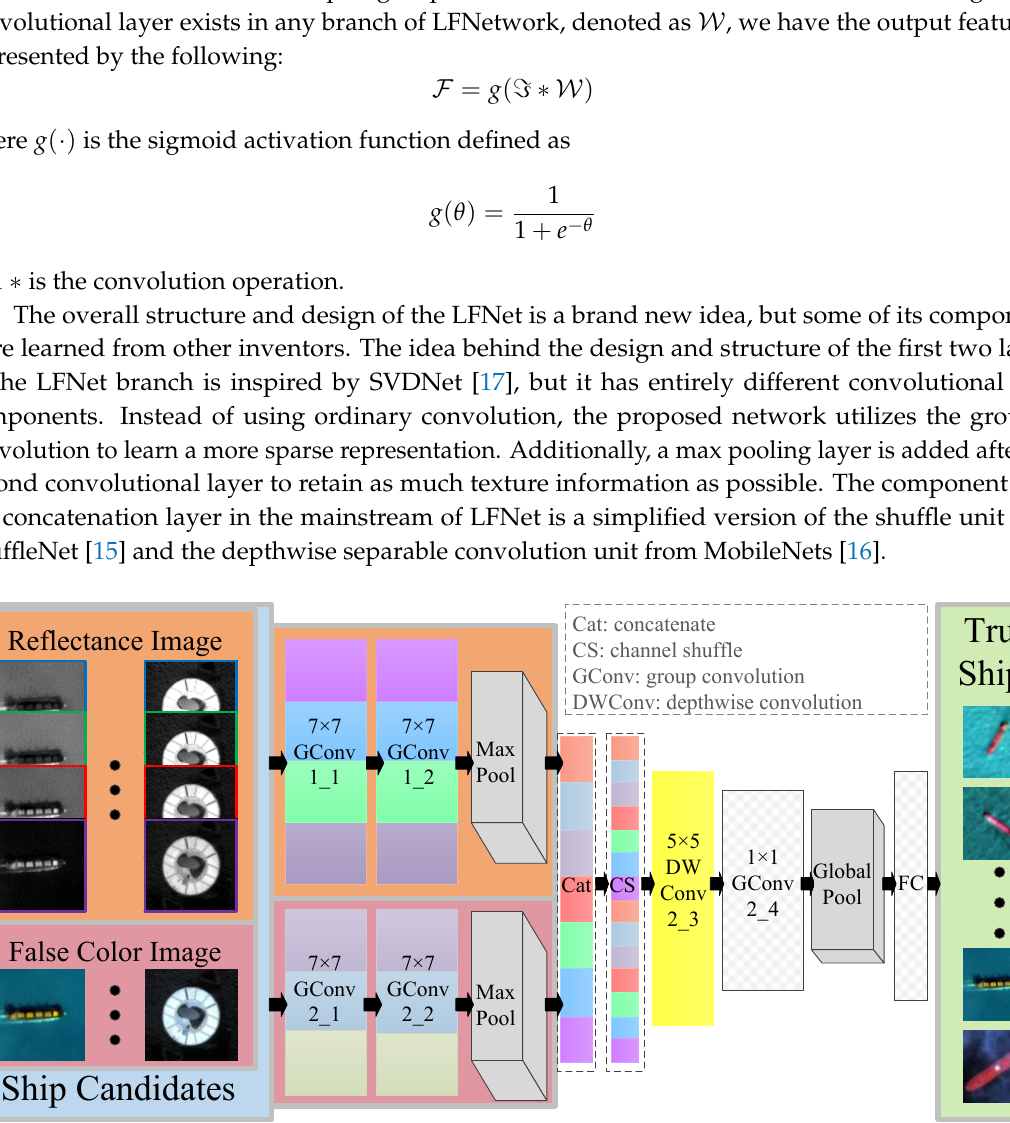
Figure 6. The architecture of the proposed network: The pink colored branch of the network receives the synthesized false color image input with two grouped convolution (GConv) layers and a max pooling layer, and the orange colored branch receives reflectance image input having the same structure as the pink colored branch. The mainstream consists of GConv, depthwise convolution (DWConv), global pooling layer, and a fully connected